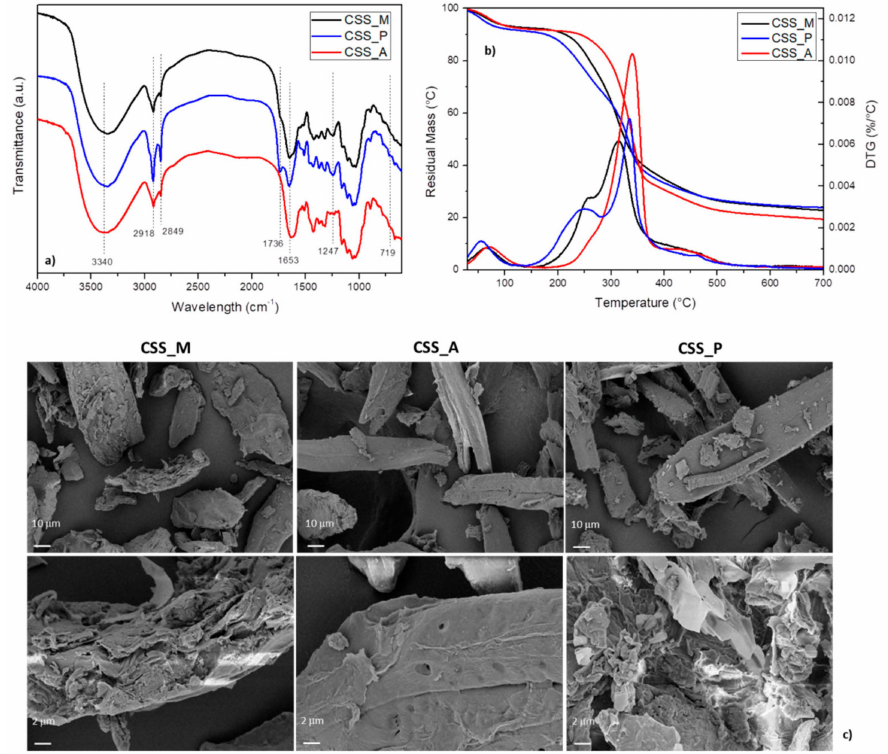
Figure 1. FTIR spectra ( a ) TG / DTG curves ( b ) and FESEM images ( c ) of untreated (CSS_M), alkali treated (CSS_A) and palmitoyl chloride treated (CSS_P) co ff ee